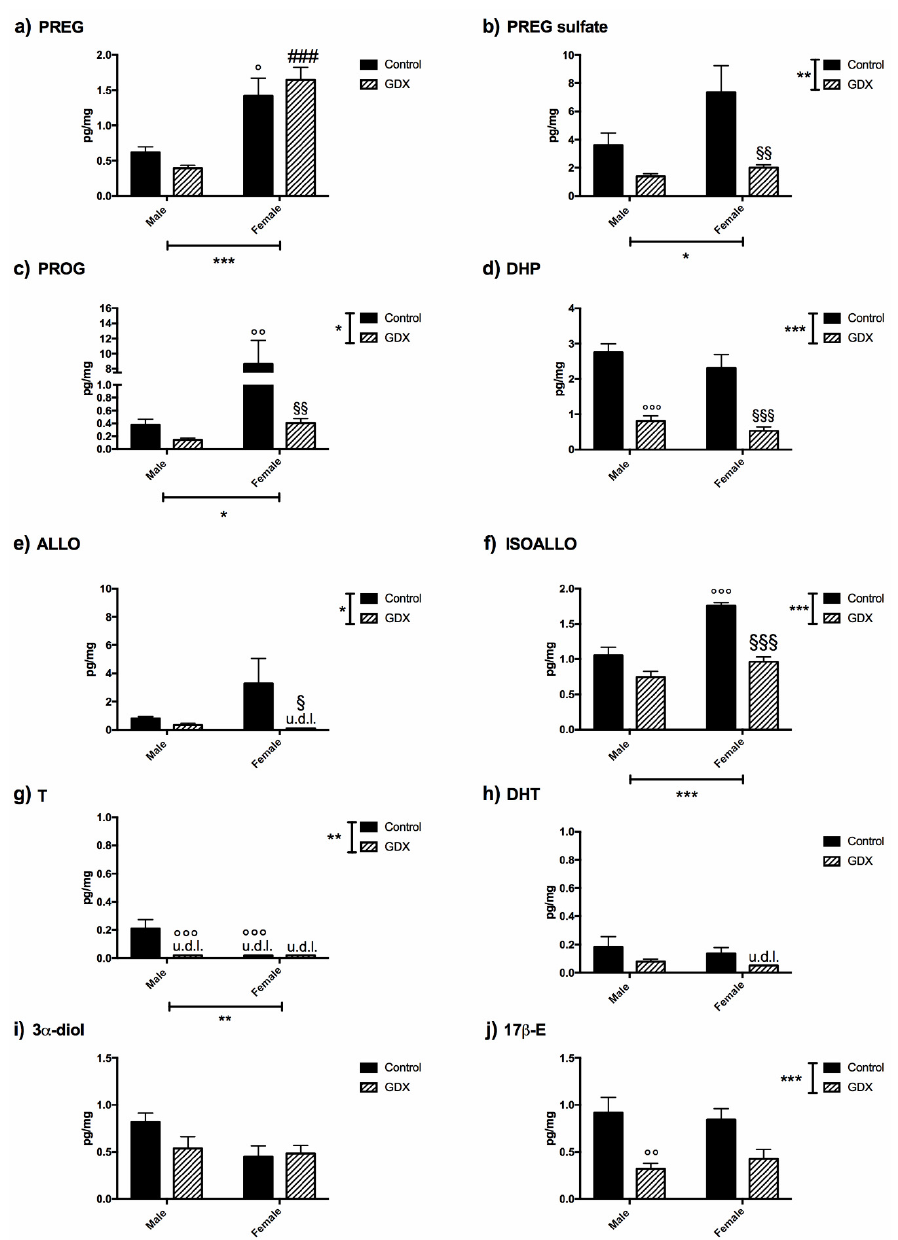
Figure 1. Steroid levels assessed by LC-MS/MS in the colons of male or female gonadectomized (GDX) rats compared with a sham-operated control. The panels represent the levels of ( a ) preg- nenolone (PREG); ( b ) pregnenolone sulfate (PREG sulfate); ( c ) progesterone (PROG); ( d ) dihy- droprogesterone (DHP); ( e ) allopregnanolone (ALLO); ( f ) isoallopregnanolone (ISOALLO); ( g ) testos- terone (T); ( h ) dihydrotestosterone (DHT); ( i ) 5 α -androstane-3 α , 17 β -diol (3 α -diol); ( j ) 17 β -estradiol (17 β -E). Data are expressed as pg/mg and are the mean ± SEM. n = 6 animals for each experi- mental group. u.d.l. = under detection limit. Limit of detection for ALLO is 0.1 pg/mg, for T is 0.02 pg/mg and for DHT is 0.05 pg/mg. The two-way ANOVA was used for statistical